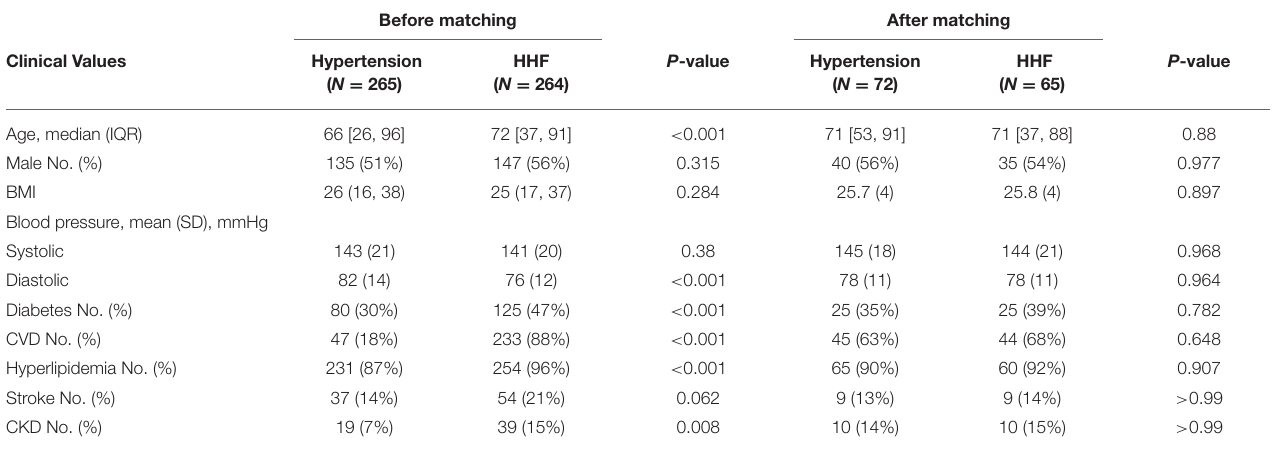
TABLE 1 | Demographic characteristics.